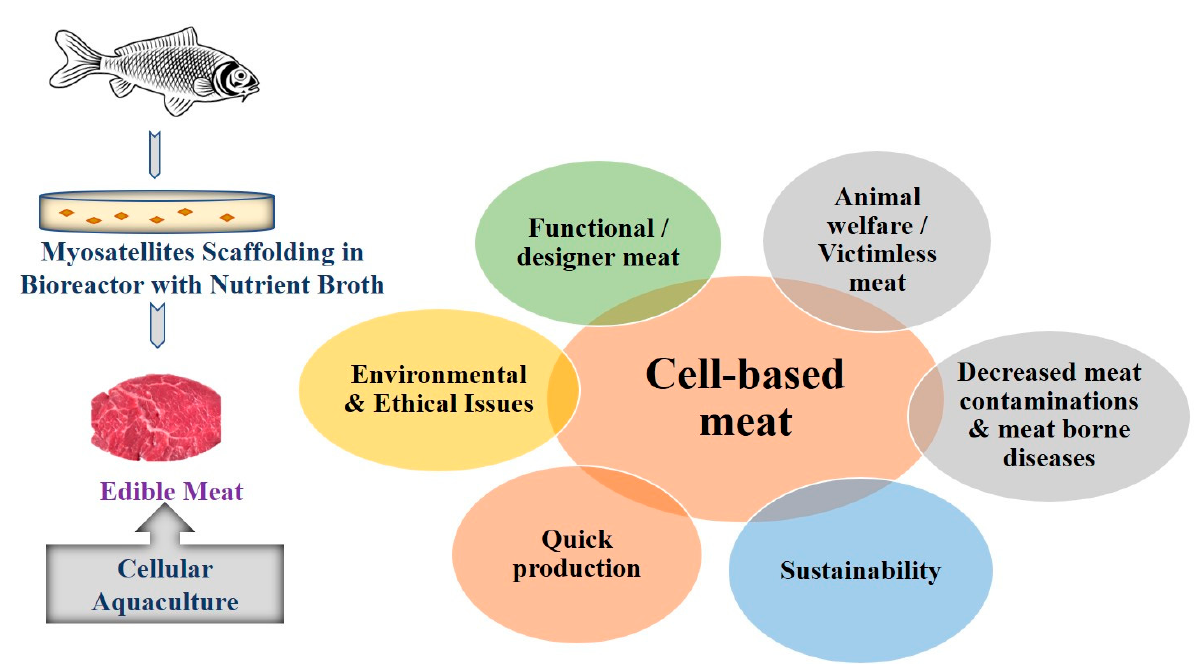
Figure 1. Application of cell-based meat production over conventional